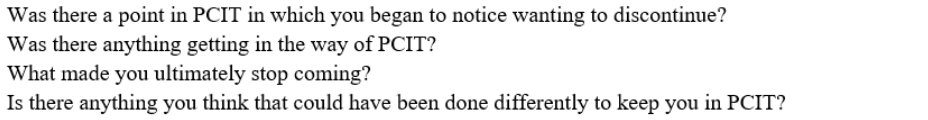
Figure 1. Interview questions.